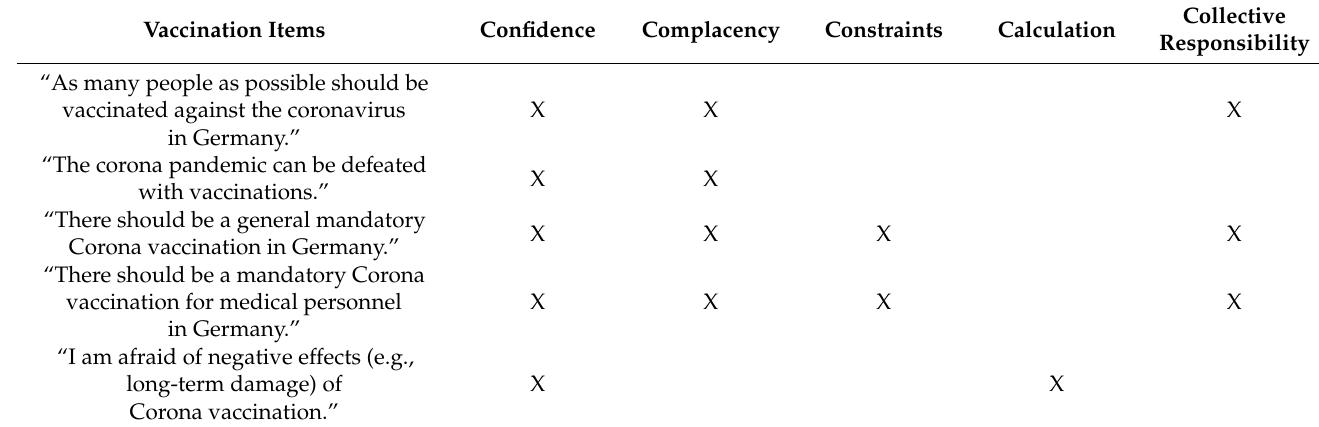
Table 1. Vaccination items and their representation in the 5C